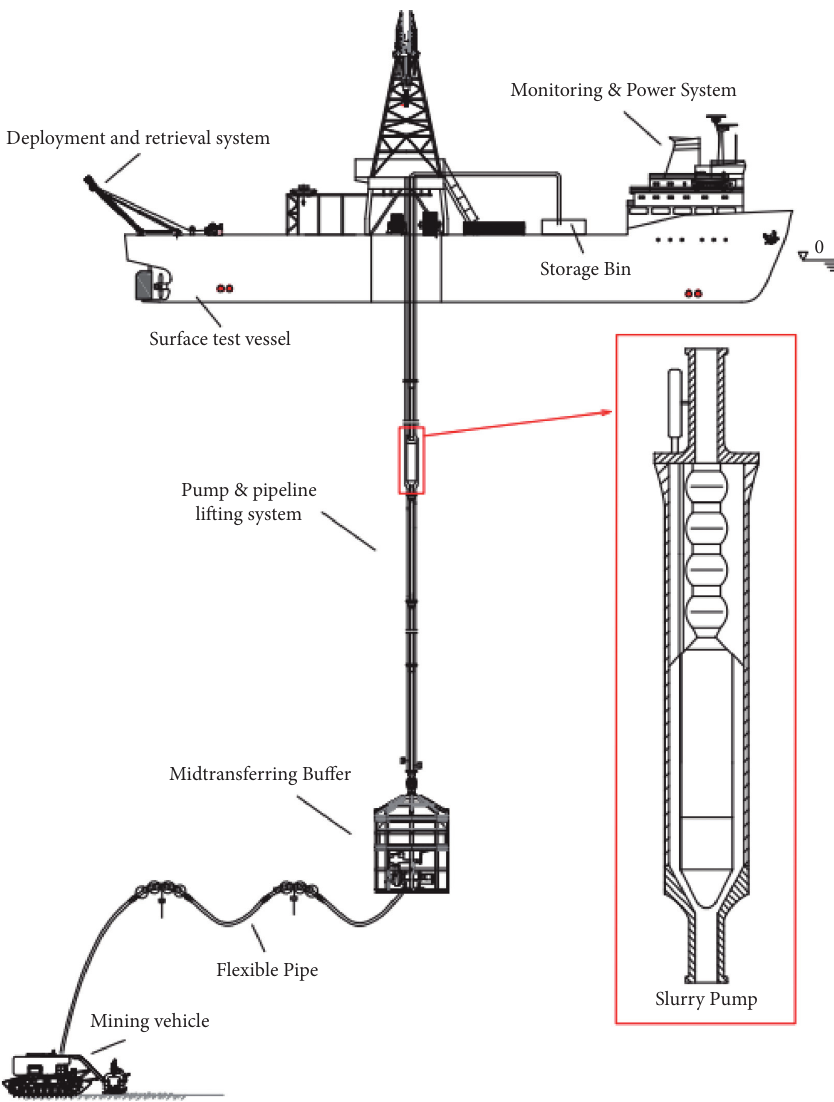
Figure 1: Pipeline lifting system of deep-sea mining